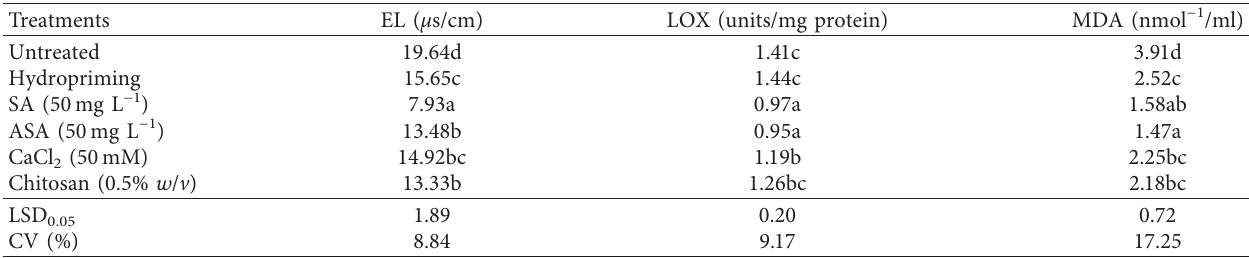
Table 3: Effects of seed priming on electrolyte leakage (EL), lipoxygenase activity (LOX), and malondialdehyde (MDA) content of peanut seed priming before 9 months of